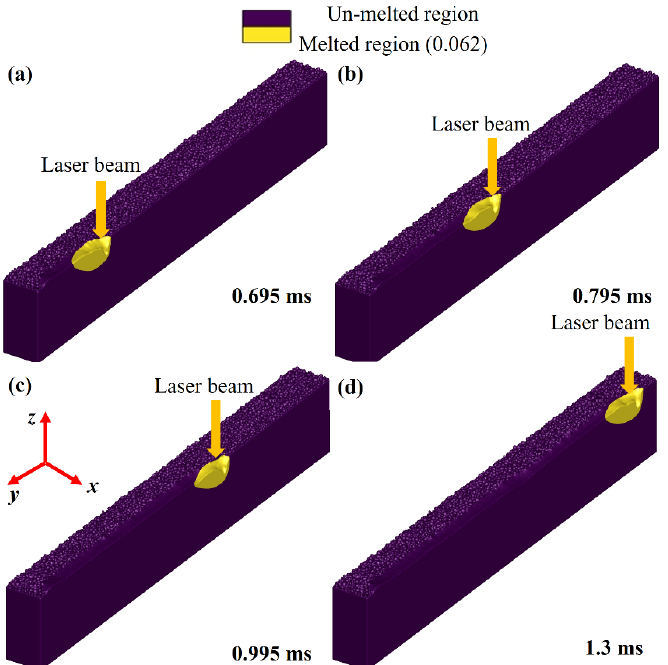
Figure 7. Un-melted and melted regions at different time intervals ( a ) 0.695 ms, ( b ) 0.795 ms, ( c ) 0.995 ms and ( d ) 1.3 ms.